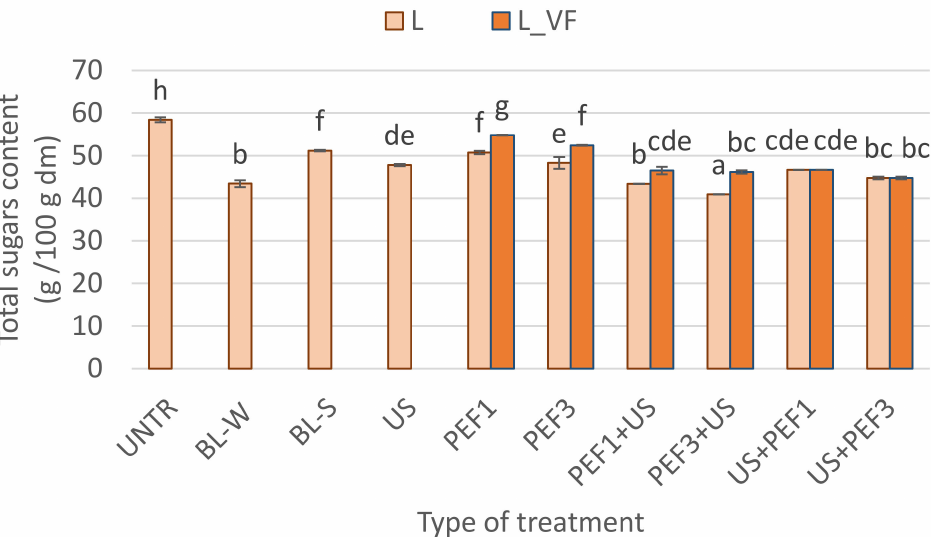
Figure 2. Total sugars content of lyophilized red bell peppers treaded with traditional treatment (BL_W—blanching in water, BL_S—steam blanching), novel single treatment (US—sonication for 30 min, PEF_1—pulsed electric field with energy input 1 kJ/kg, PEF_3—pulsed electric field with energy input 3 kJ/kg) or novel hybrid treatment (PEF+US, US+PEF), preceded by shock freezing